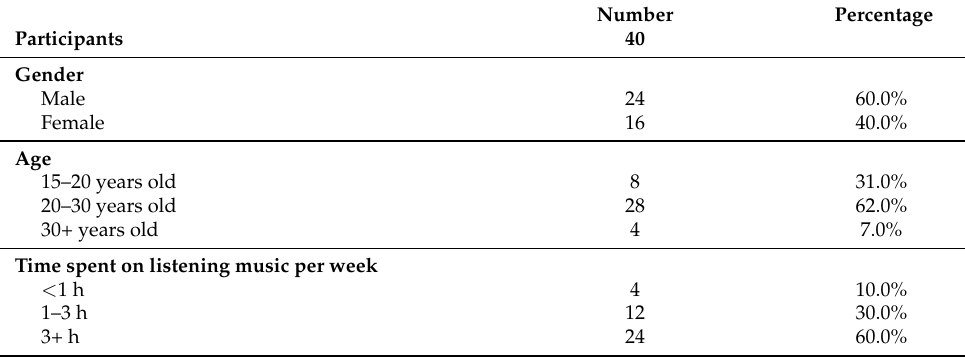
Table 4. Participant’s